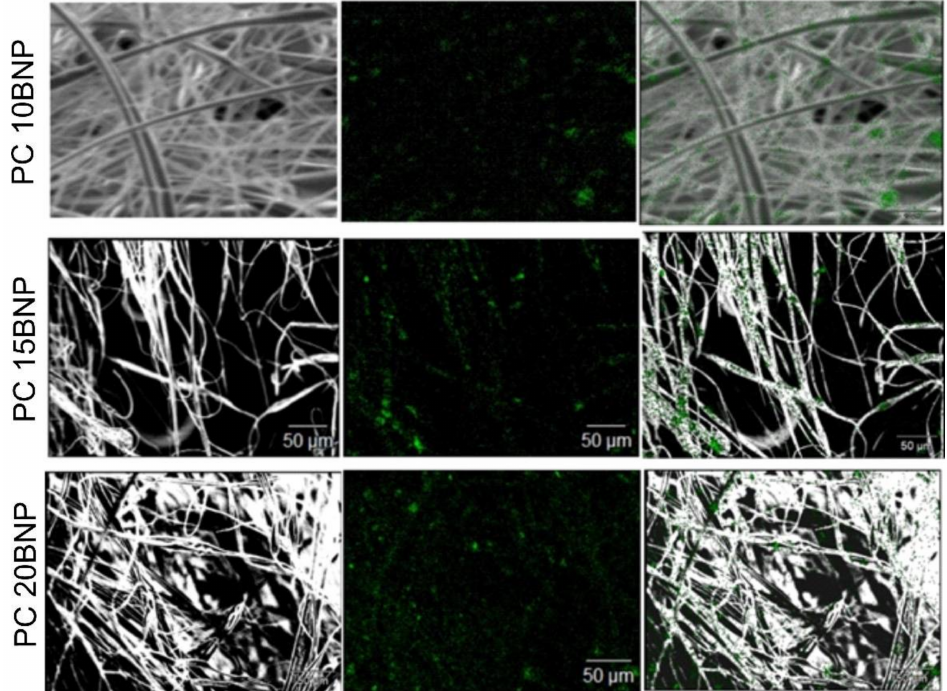
Figure A1. SEM ( Left ), EDX elemental maps showing the Al signal of the fibers ( Middle ) and their superposition ( Right